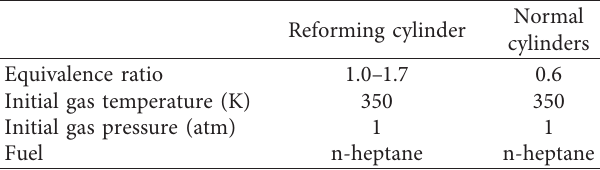
Table 2: Operation conditions of HCCI engine.